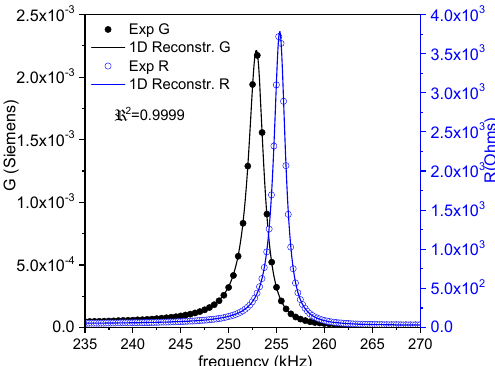
Figure 2. Fundamental radial extensional resonance mode of a thickness-poled and excited thin disk. Impedance spectra in an ( R , G ) plot of a disk with a diameter of 12 mm and t = 1.15 mm. The symbols are the experimental data, and the lines are the reconstructed peaks after the calculation of the coefficients. The value of the regression factor for this calculation ( ℜ 2 ) is shown. The black symbols and lines ( G data) can be read in the left-y-axis, and the blue ones ( R data) are in the right-y-axis.